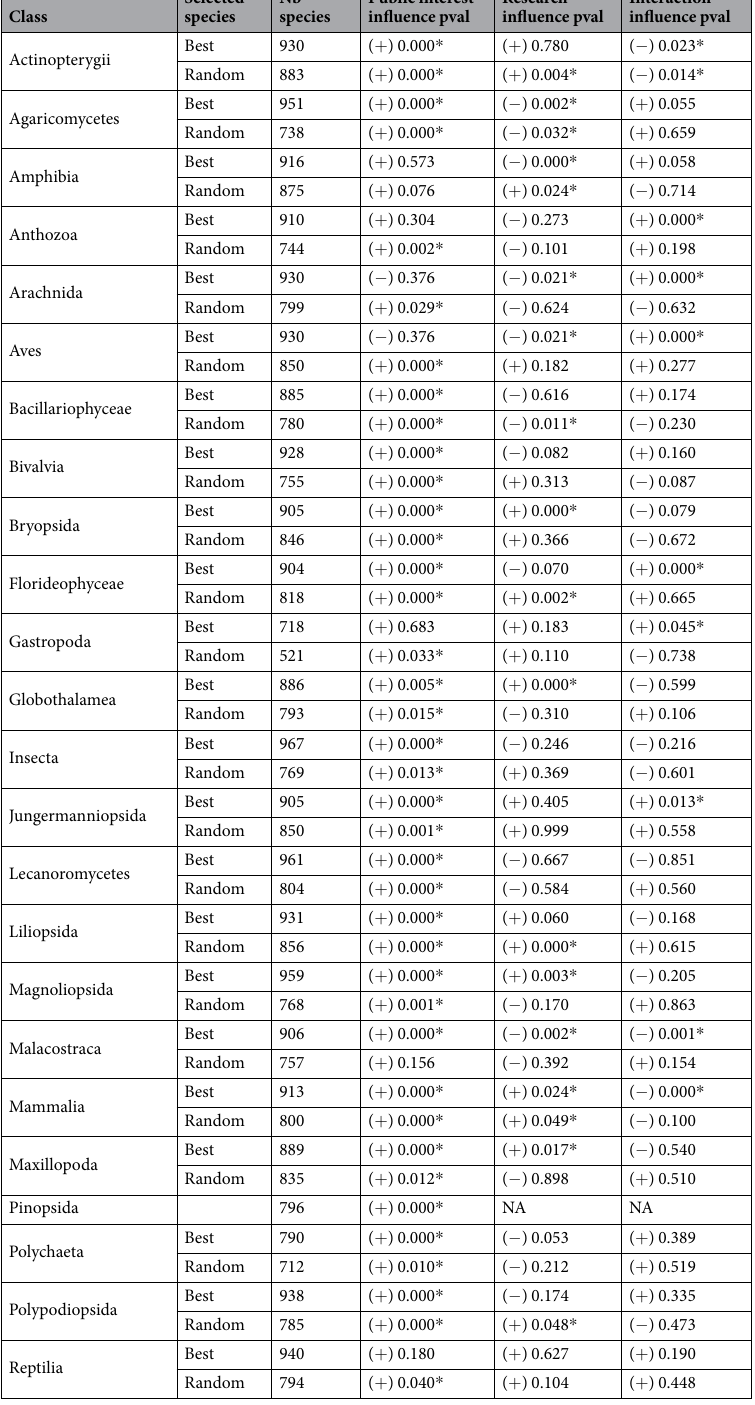
Table 3. GLM results assessing the link between research quantity, public interest and their combined interaction on the amount of biodiversity data per class. A positive correlation between public interest and the number of occurrences was found in most classes. Values followed by * have a significant p-value at a 5% threshold. ( + ) indicates a positive influence while ( - ) indicates a negative influence of the variable on the number of occurrences. Nb species = number of species used in the GLM after removing outliers; pval = p-values; NA = not available (because no order information and therefore no research quantity was available for